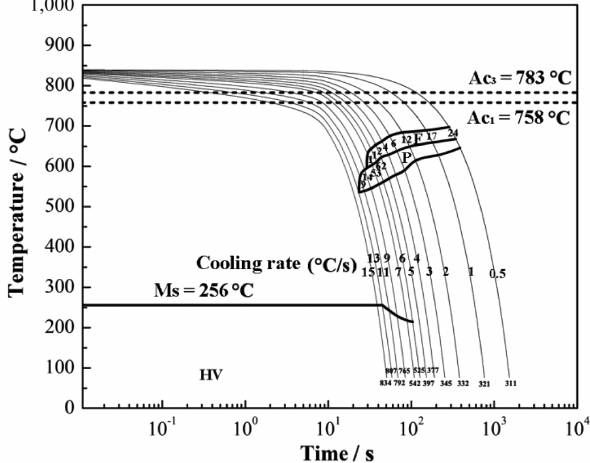
Figure 2: The CCT curve of 60Si2MnA spring